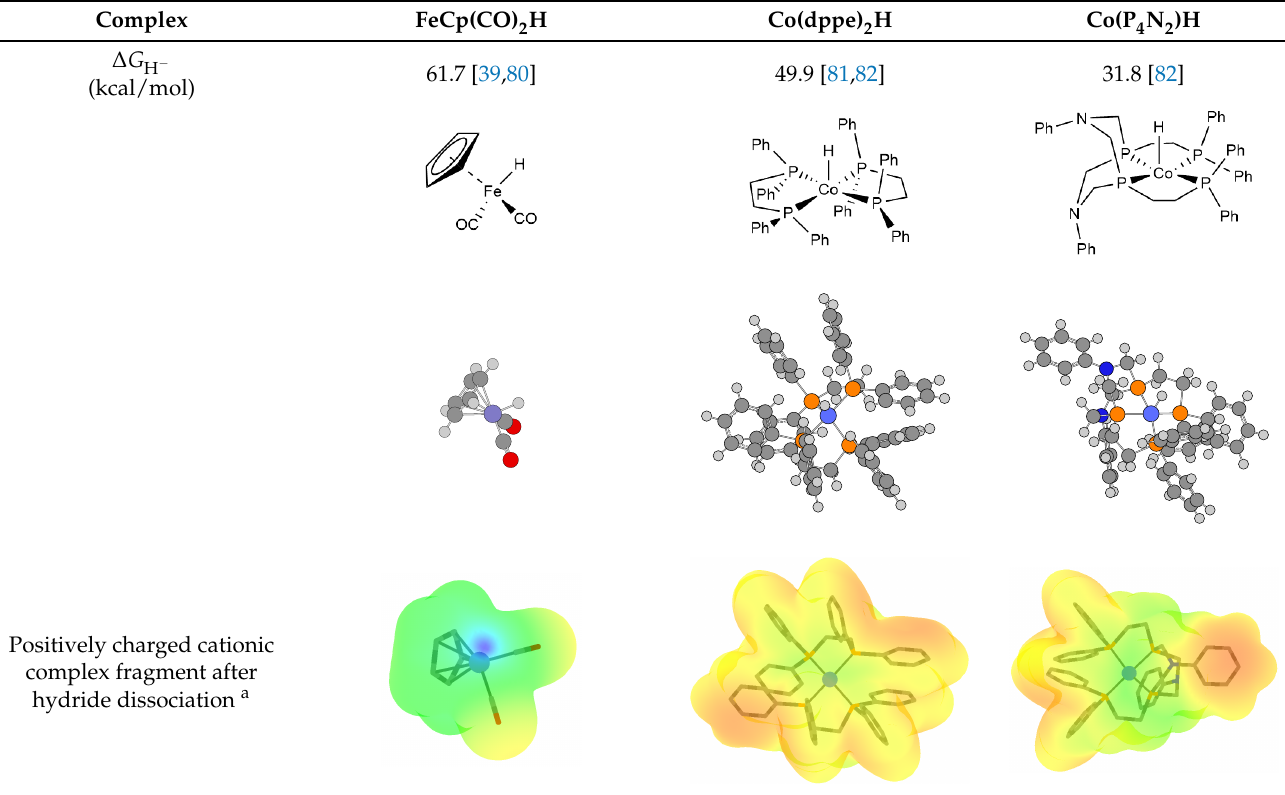
Table 2. Three 3d transition metal complexes with experimentally determined thermodynamic hydricity values ( ∆ G